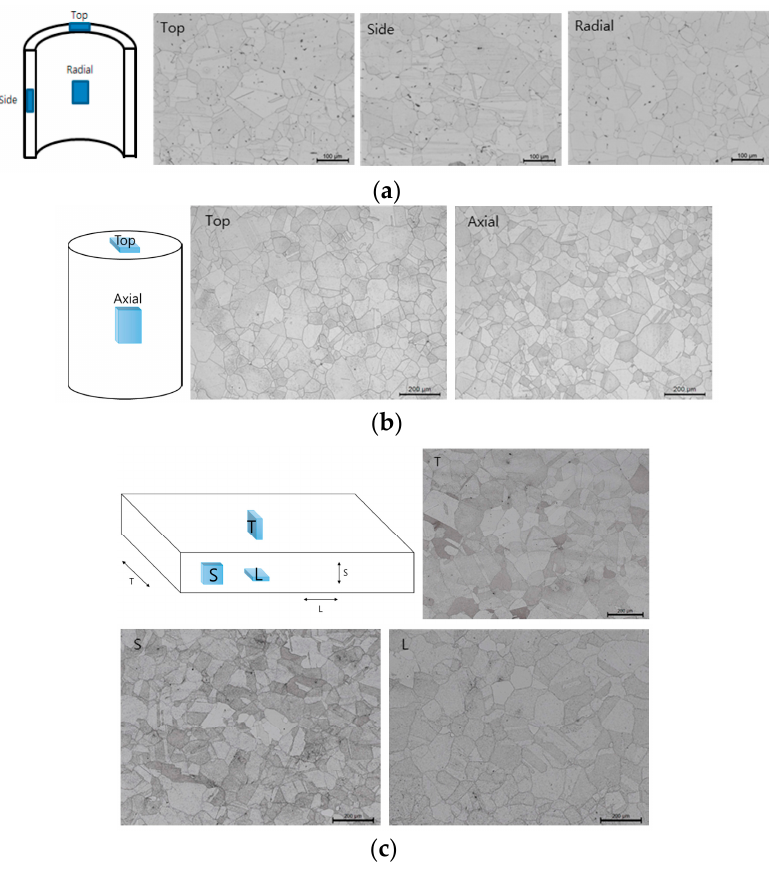
Figure 1. Microstructure of three heats of Alloy 600. ( a ) ‘Tube’; ( b ) ‘Rod’; ( c ) ‘Plate’. Table 1. Chemical composition of Alloy 600 heats used in the study (in wt%).